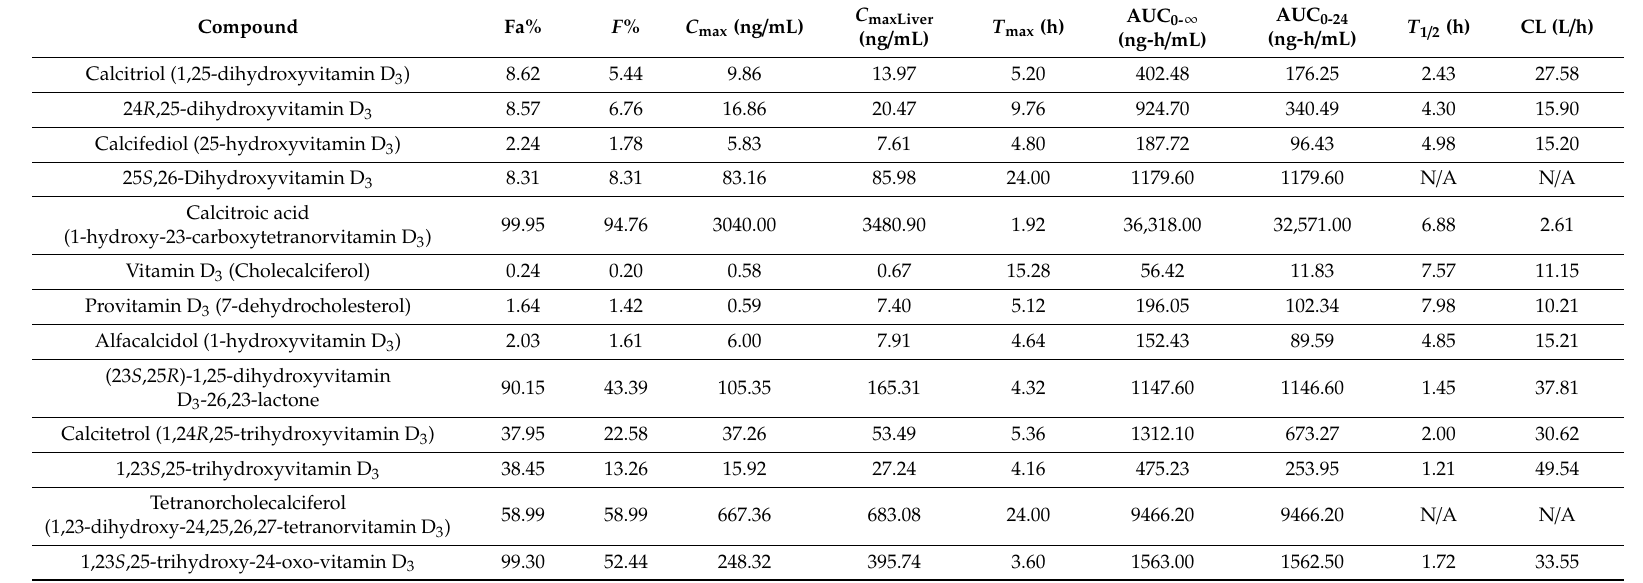
Table 3. Predicted pharmacokinetic parameters of provitamin D 3 (precursor of vitamin D 3 ) and vitamin D 3 derivatives at a dose of 100 mg. The PKPlus platform was used in a single compartment